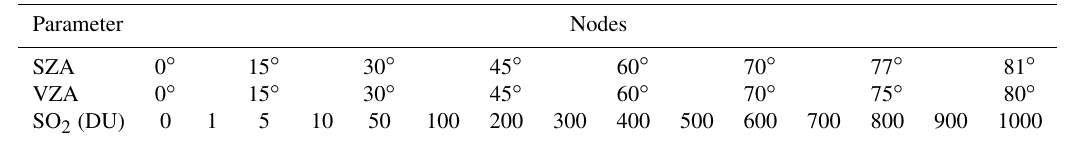
Table 1. Nodes of the solar zenith angle (SZA), viewing zenith angle (VZA), and SO 2 column amount, as used in the pre-computed SO 2 Jacobians lookup tables. Parameter Nodes